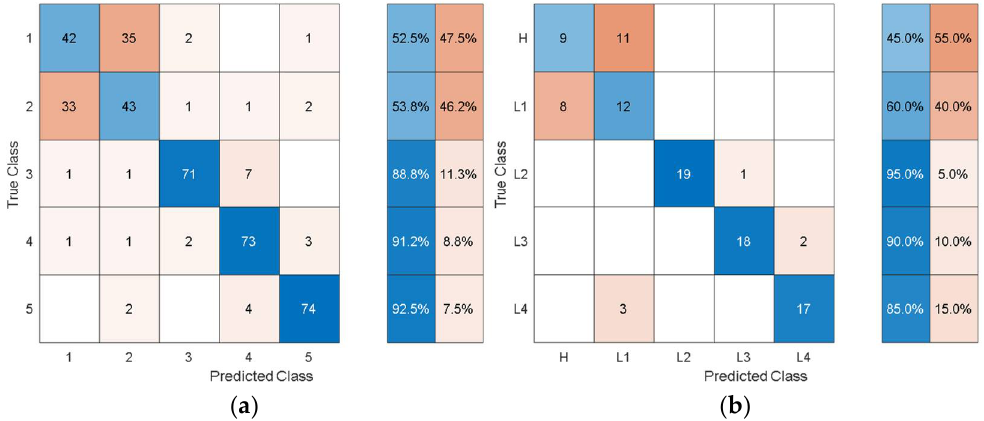
Figure 11. Classification performance of SVM using the autonomous features from the 66th layer of SqueezeNet in terms of its confusion matrices: ( a ) training; ( b ) test.